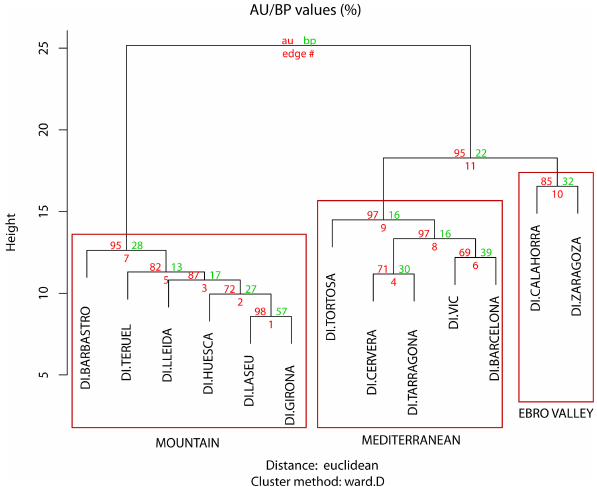
Figure 3. Dendrogram showing the hierarchical cluster analysis of the drought indices developed from the historical documents for each location. The AU (approximately unbiased p value) is indi- cated in red and the BP (bootstrap probability) is presented in green.